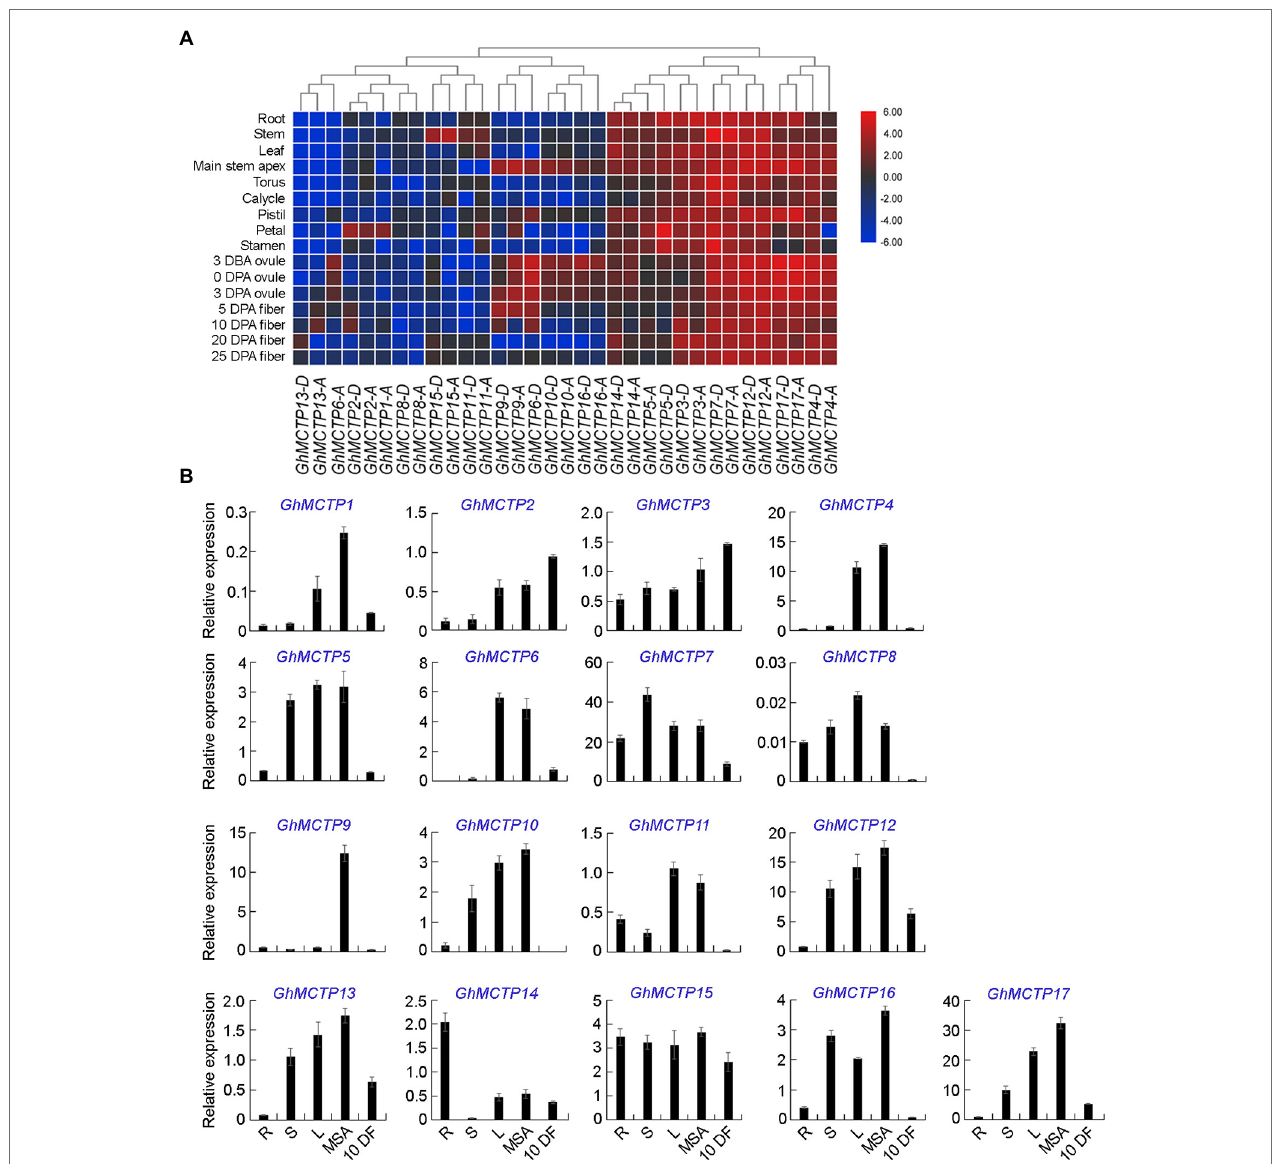
FIGURE 3 | Expression patterns of GhMCTPs in upland cotton. (A) Heat map analysis of GhMCTP gene expressions in different organs of upland cotton. The relative fold changes in gene expression for all GhMCTP genes were compared. The color from blue to red indicates low to high expression. DBA, days before- anthesis; DPA, days post-anthesis. (B) Quantitative real-time PCR (qRT-PCR) analysis of 17 GhMCTPs in various tissues of upland cotton. Results were normalized against the expression level of GhUBI1 . R, root; S, stem; L, leaf; MSA, main stem apex; and 10 DF, fibers at 10-day post-anthesis. Error bars indicate